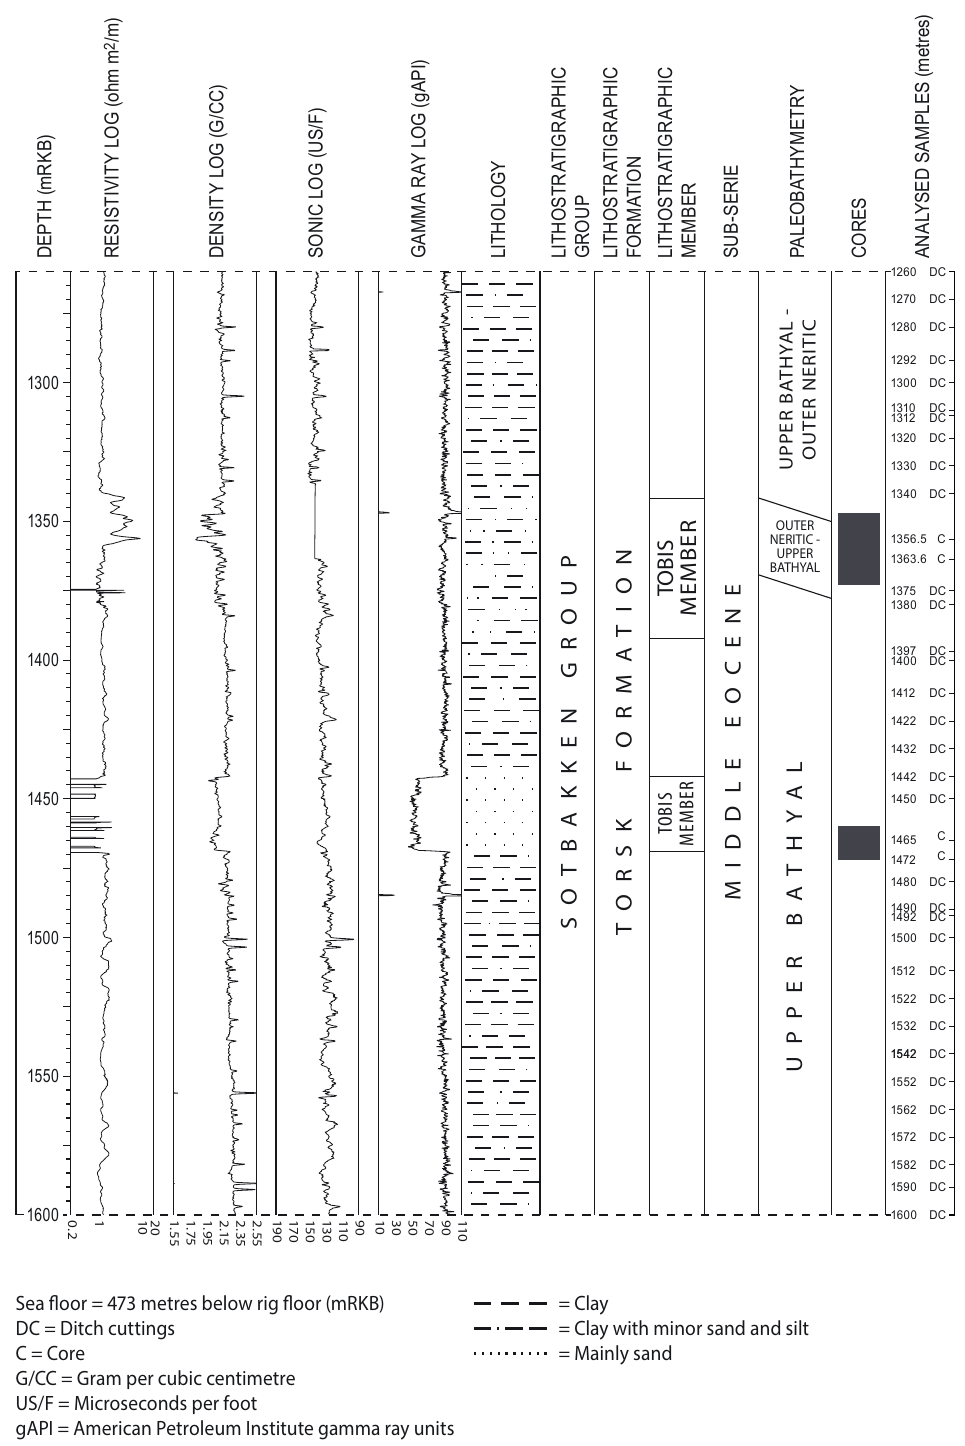
Sea floor = 473 metres below rig floor (mRKB) DC = Ditch cuttings C = Core G/CC = Gram per cubic centimetre US/F = Microseconds per foot gAPI = American Petroleum Institute gamma ray units Figure 13. Well summary figure including resistivity log, density log, sonic log, gamma-ray log, lithology, litho- stratigraphic units, sub-series, paleobathymetry, cores and analysed samples for the lower part of the investigated sequence in well 7316/5–1 (middle Eocene) including the middle part of the supplementary well reference section for the Torsk Formation (modified after Eidvin et al., 1995, 1998b,